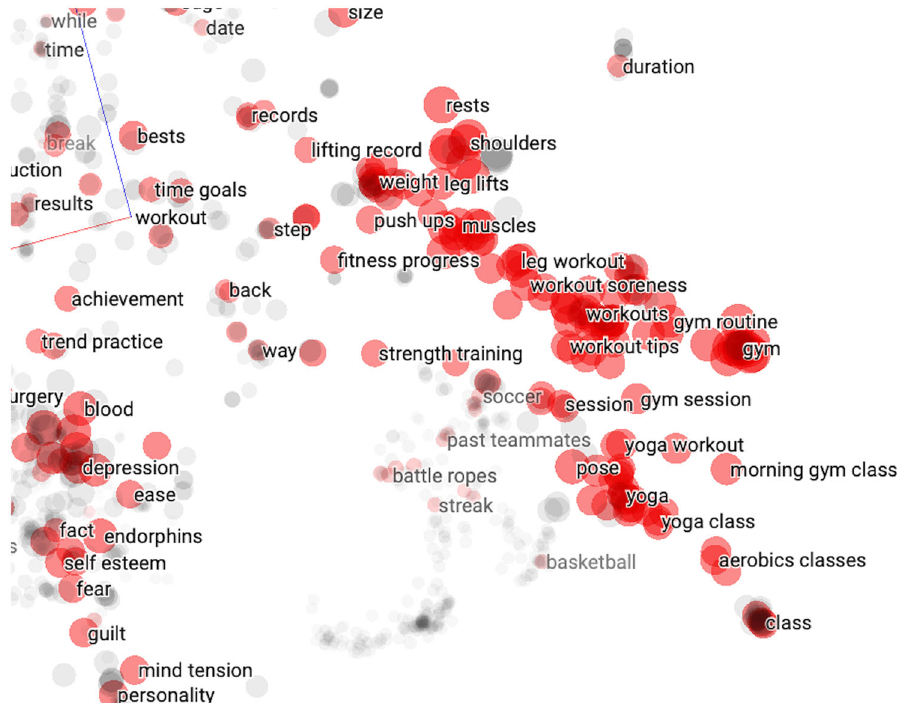
Fig. 4 3D vector space visualization of EXERCISE keywords. The keyword clusters show that keywords associated with physical activities are the majority.